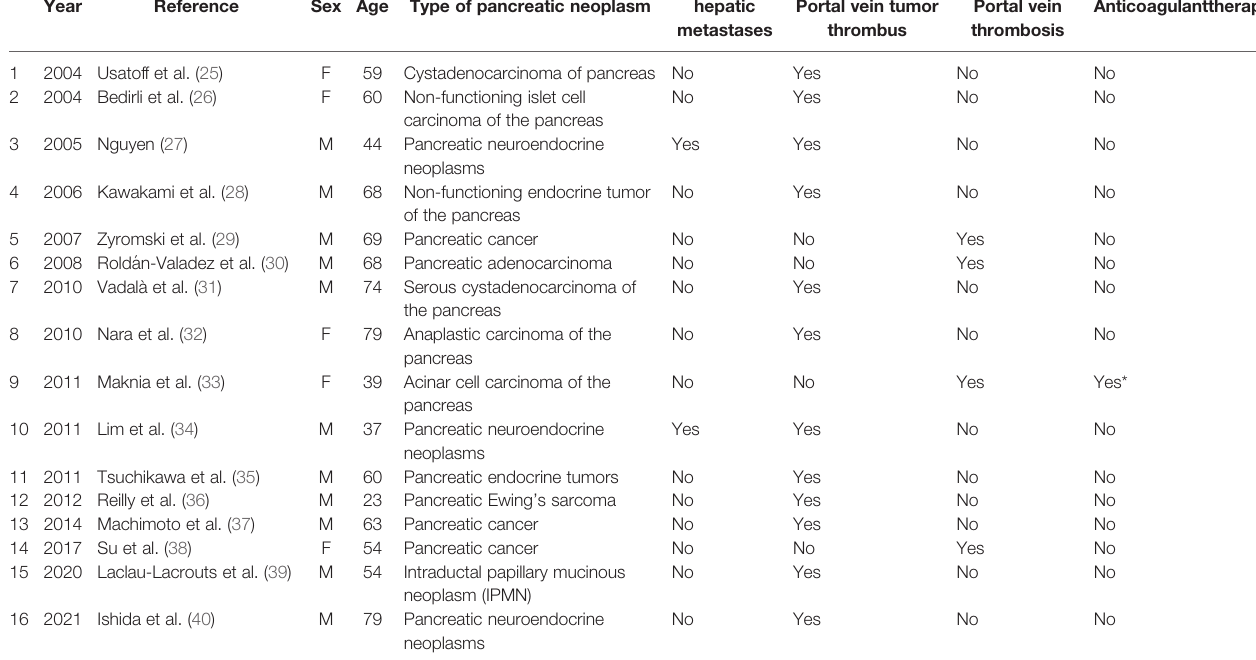
TABLE 1 | Full-text case reports of patients with pancreatic neoplasms with liver metastases and portal vein thrombosis.